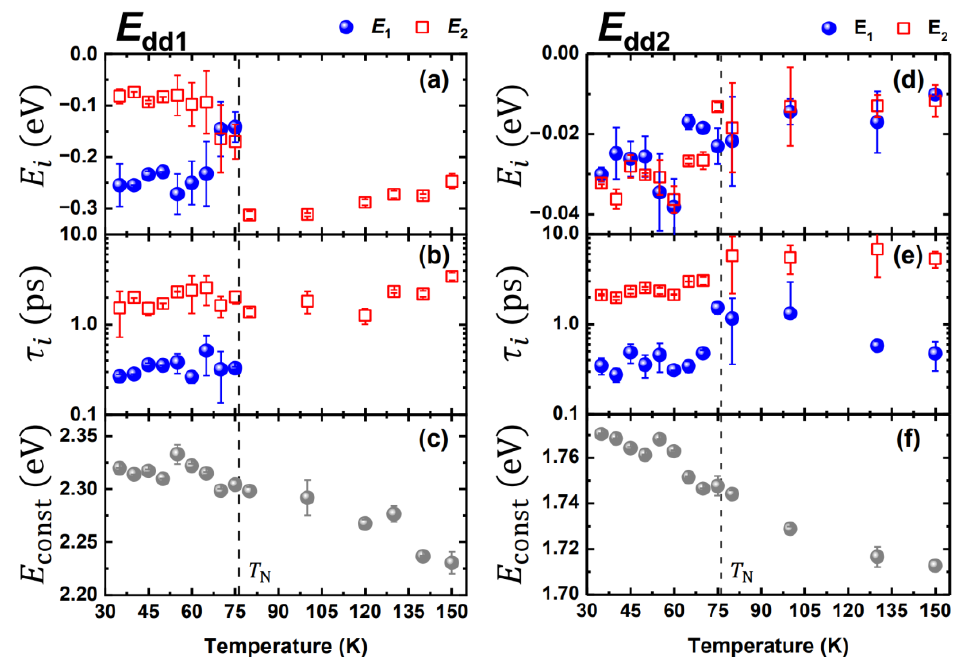
Figure 4. Fitting results of the E dd1 ( e 1g → a 1g ) and E dd2 ( e 2g → a 1g ) spectra in Figure 3 obtained by using Equation (1). ( a , d ) Amplitudes E 1 and E 2 , ( b , e ) relaxation times 𝜏 1 and 𝜏 2 of E dd1 and E dd2 spectra at various temperatures. ( c , f ) The constant term of Equation (1) for the energy relaxations in E dd1 and E dd2 spectra. The black dashed lines indicate T N .